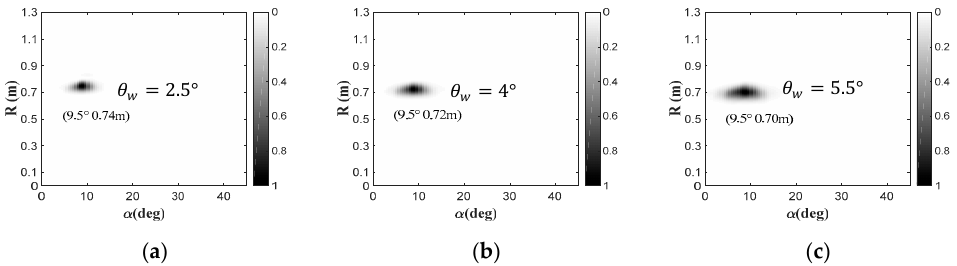
Figure 12. Comparisons of the results by the CSAFT method for excitation signals with different cycles: ( a ) five cycles; ( b ) seven cycles; ( c ) nine cycles. θ w is the angular bandwidth of the defect Table 2. The numbers of the receiving signals for different angular steps.